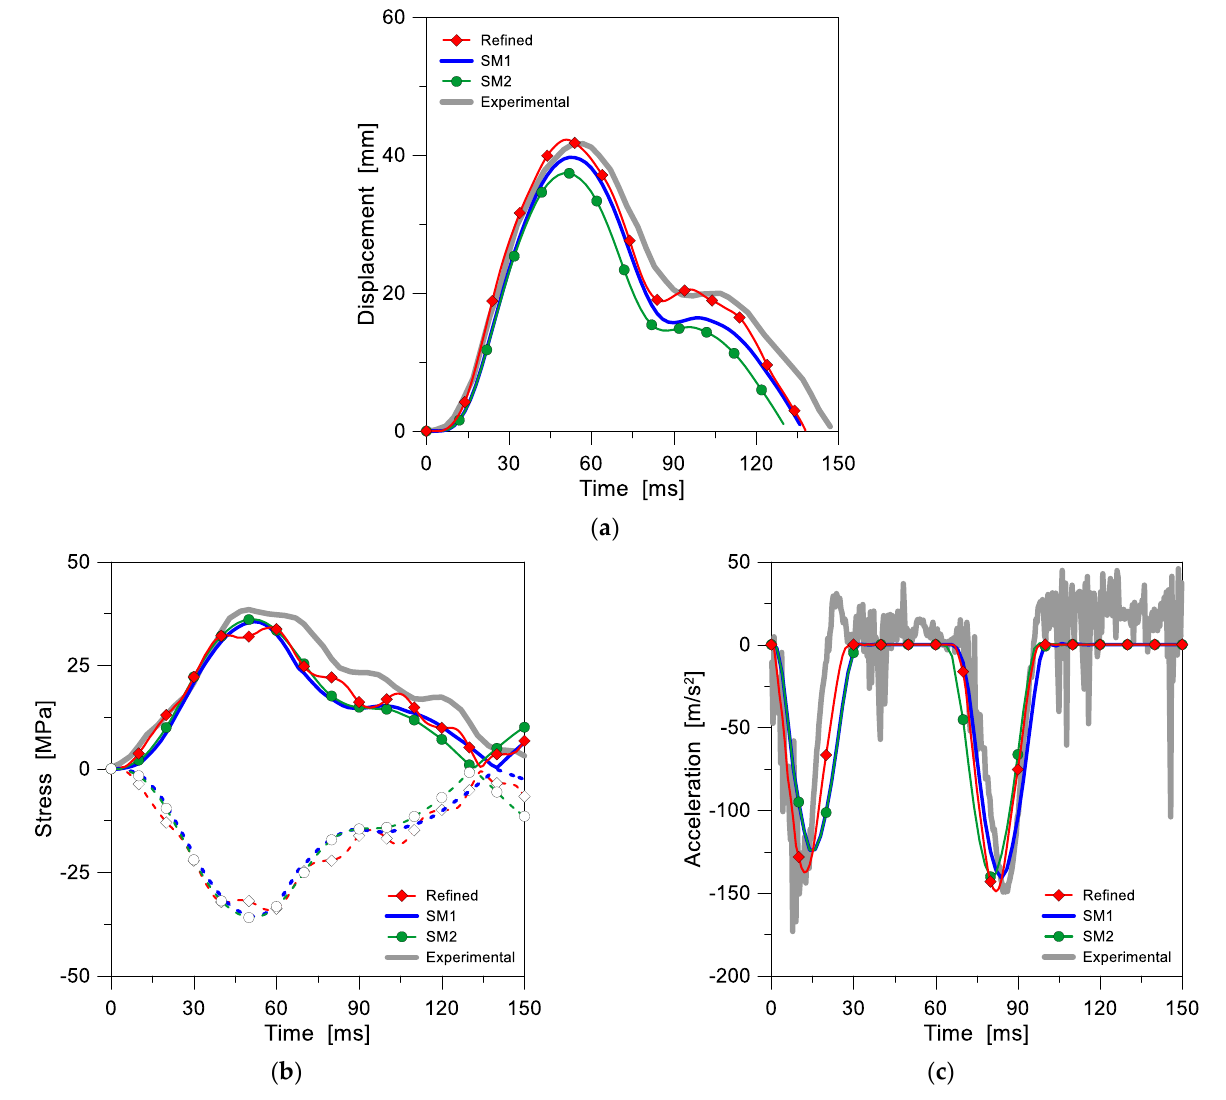
Figure 14. Numerical analysis of Refined, SM1, and SM2 simplified models (ABAQUS) under double twin-tyre impact (300 mm being the drop height): ( a ) lateral displacement; ( b ) maximum principal stress in glass (dashed lines for compression side), and ( c ) acceleration time histories.